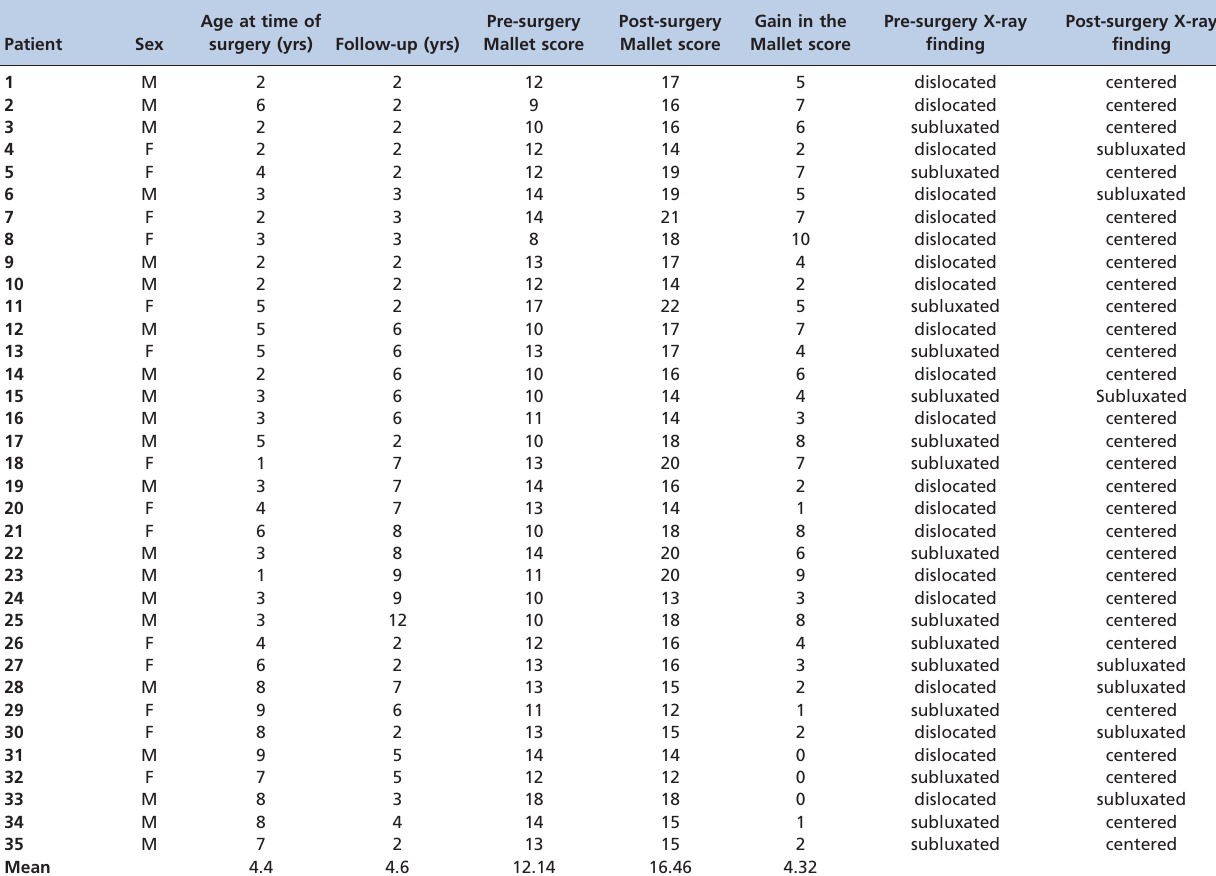
Table 1 - Pre- and postoperative clinical and radiographic patient data. Age at time of Patient Sex surgery (yrs) Follow-up